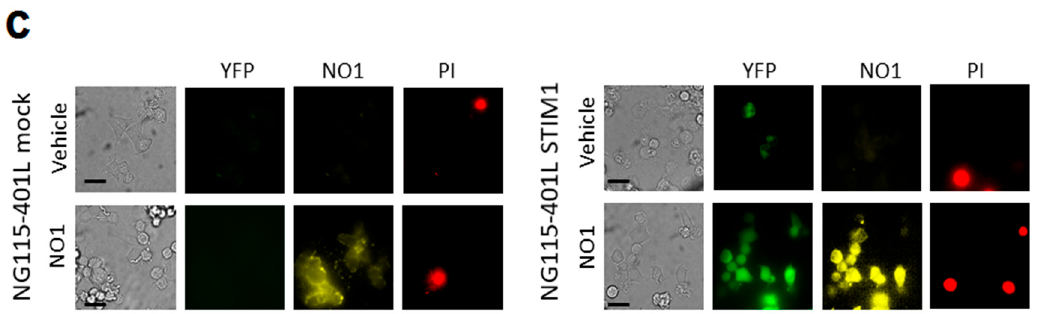
Figure 8. NO1 evoked cell death in NG115-401L artificially expressing STIM1. ( a ) MCF10A, MDA-MB-231, and NG115-401L cells growing under normal conditions were detached and suspended in different Phosphate buffer saline (PBS) buffers in order to obtain a similar number of cells/mL. Cells were then centrifuged and suspended in Laemmli’s buffer and suggested to WB using anti-TMEM97 and anti-STIM1 antibodies as described in the Material and Methods section. The histogram represents the fold increase of STIM1 and σ 2R/TMEM97 expression values compared to those found in MCF10A upon normalization with actin, which was used as loading control. *, **, and *** represent p < 0.05, <0.01, and 0.001, respectively, with respect to the values found in MCF10A. ( b , c ) NG115-401L and NG115-401L overexpressing STIM1 were shed at the appropriated concentration, and after transfection was confirmed by fluorescent microscopy, cells were incubated for 45 min with propidium iodide (PI) in the incubator, and during the final 30 min, the extracellular medium was supplemented either with the vehicle or with NO1 (100 nM). When incubation time was over, cells were observed in the middle plane under an epifluorescent microscope using a 100x objective. ( b ) Histogram represents the percentage of positive PI stained cells upon treatment cells with NO1 vs. nontreated cells, for which results were derived by analyzing around 200 cells from four different independent transfections. Bars in the images represent 50 μ m.